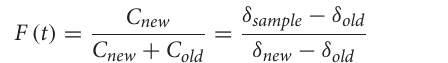
Maize (M-irr and